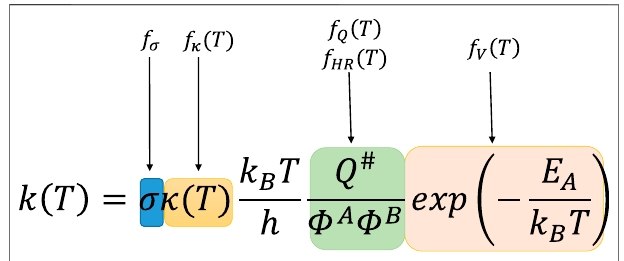
FIGURE 1 | Classical Transition State Theory (CTST) formula with marked correspondences to RC-TST factors. In this formula, σ stands for symmetry number (reaction multiplicity); T is the temperature in Kelvins ; κ (T) is the quantum tunneling coef fi cient; k B and h are Boltzmann and Planck constants; Q # , Φ A, and Φ B symbolize total partition functions of the transition state and both reactants; E A is activation energy.